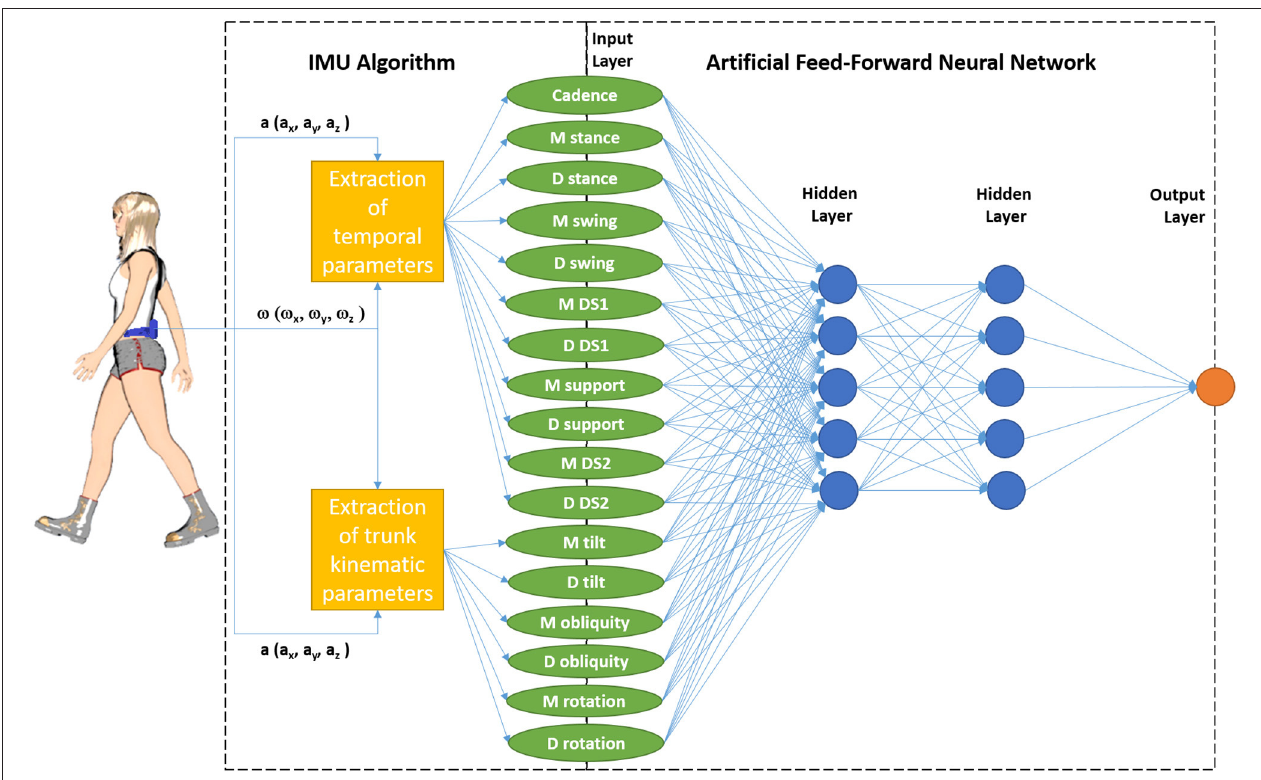
FIGURE 1 | Schematic representation of the combination of Inertial Measurement Unit (IMU, measuring triaxial acceleration a, and triaxial angular speed ω ) and its software with the feedforward neural network formed by an input layer (M stands for mean values between right and left strides, and D for their difference, DS 1 and 2 for first and second double support phases; support is the phase with only one foot on the ground), two hidden layers, and an output layer (which represents the identification of patients in the first analysis and the identification of patients who did not return to work in the second